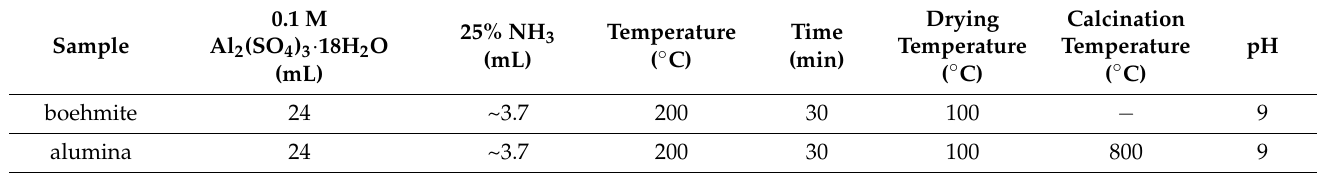
Table 1. Experimental conditions for boehmite and alumina NPs preparation.